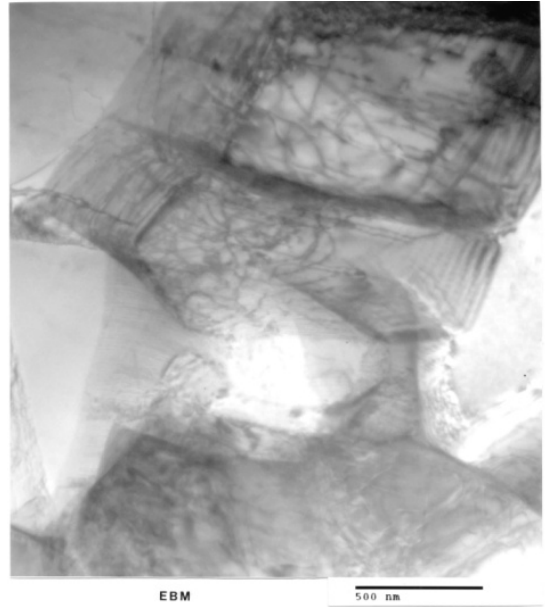
Figure 11. Magnified (TEM) view of α -grains in EBM Ti-6Al-4V sample showing dislocations. α -phase grains are inclined to the specimen surface. Average grain size is ~800 nm (0.8